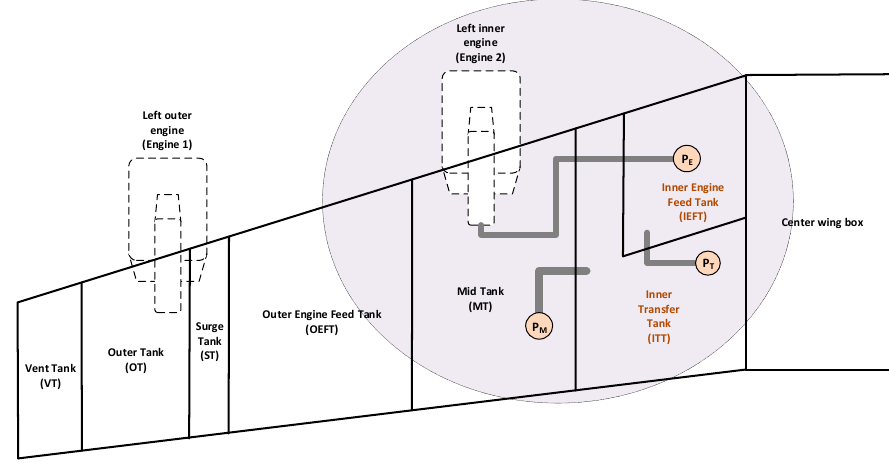
Figure 4. Fuel tank system for the Airbus A380-800 left wing (adapted view from [6]).